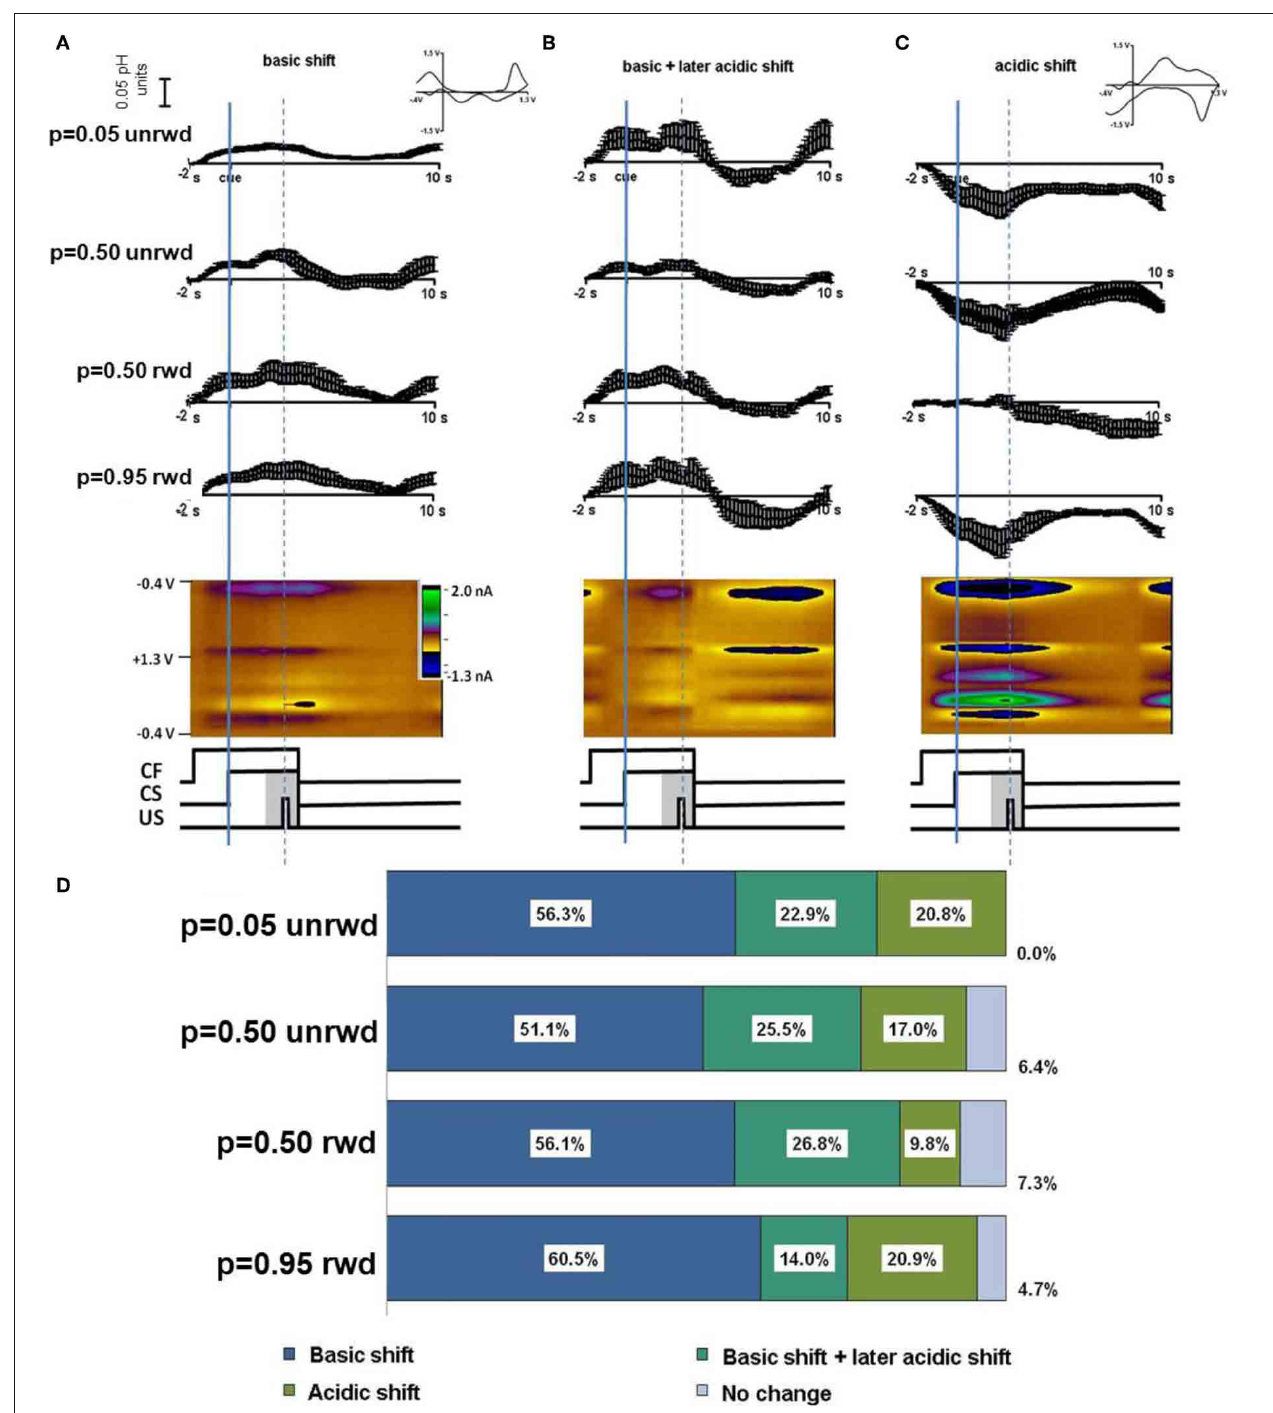
95% probability trials only rewarded trials are shown. The cue was initiated at timestamp 0s and the reward was delivered at the dotted line (in rewarded trials). (D) A summary of the percentage of responses by probability cue type. The largest number of responses was a basic shift (blue, n = 100 responses overall) a basic shift followed by an acidic shift (turquoise, n = 40 responses overall) or a long term acidic shift (green, n = 26 responses overall). A small percentage of responses showed no change (purple, n = 8 responses